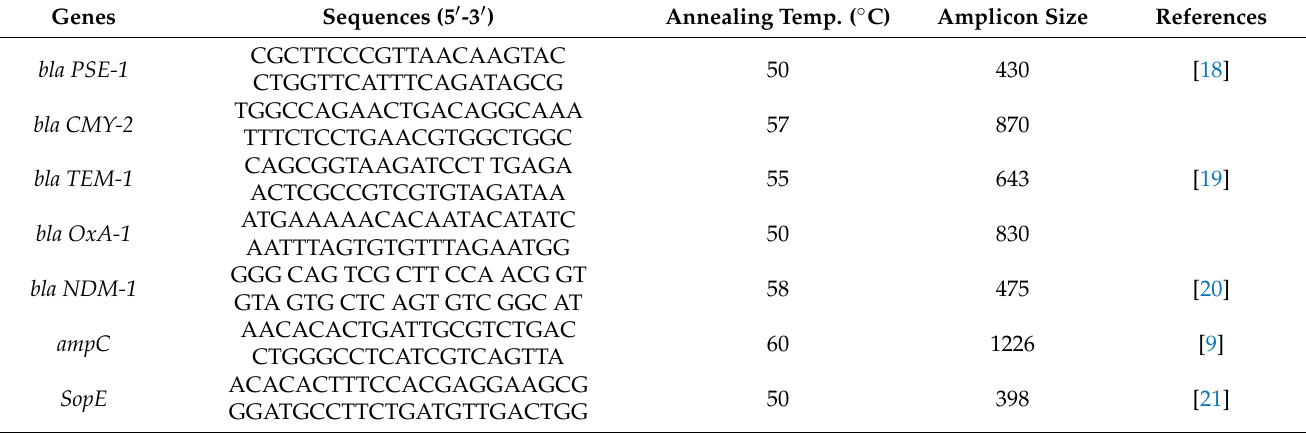
Table 2. Primers and PCR conditions used for antibiotic resistance genes and virulence factor detection.